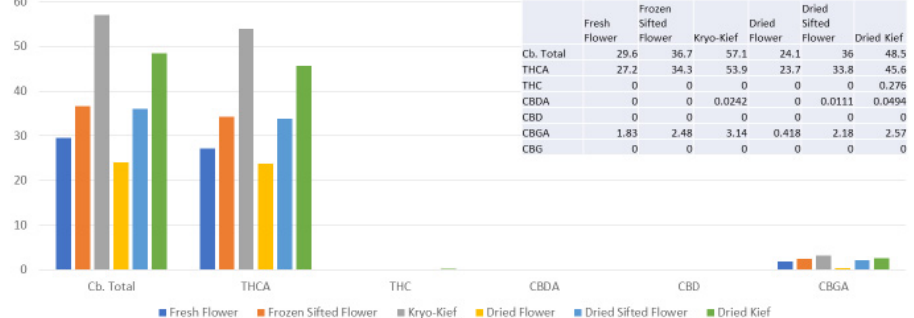
Figure 7. Ursa Major Type I chemovar cannabinoid assay results (all figures are %). Figure 8. Ursa Major Type I chemovar cannabinoid assay results (all figures are %).